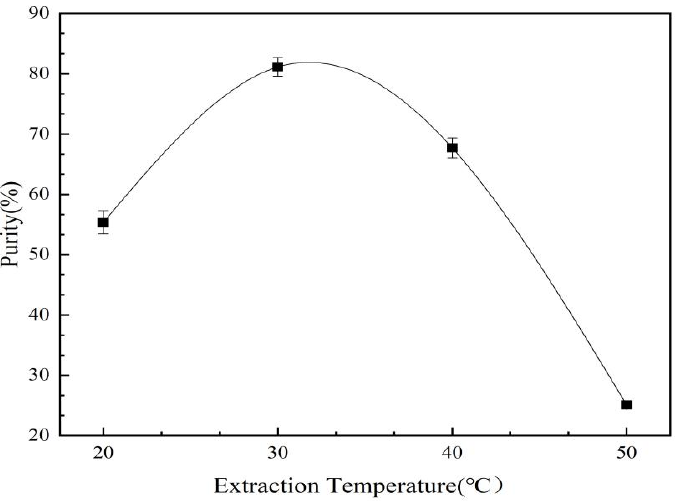
Figure 8. Effect of extraction temperature on the purity of C. oleifera saponins aqueous two-phase extraction (mass fraction of propanol = 11%; mass fraction of ammonium sulfate = 10%).